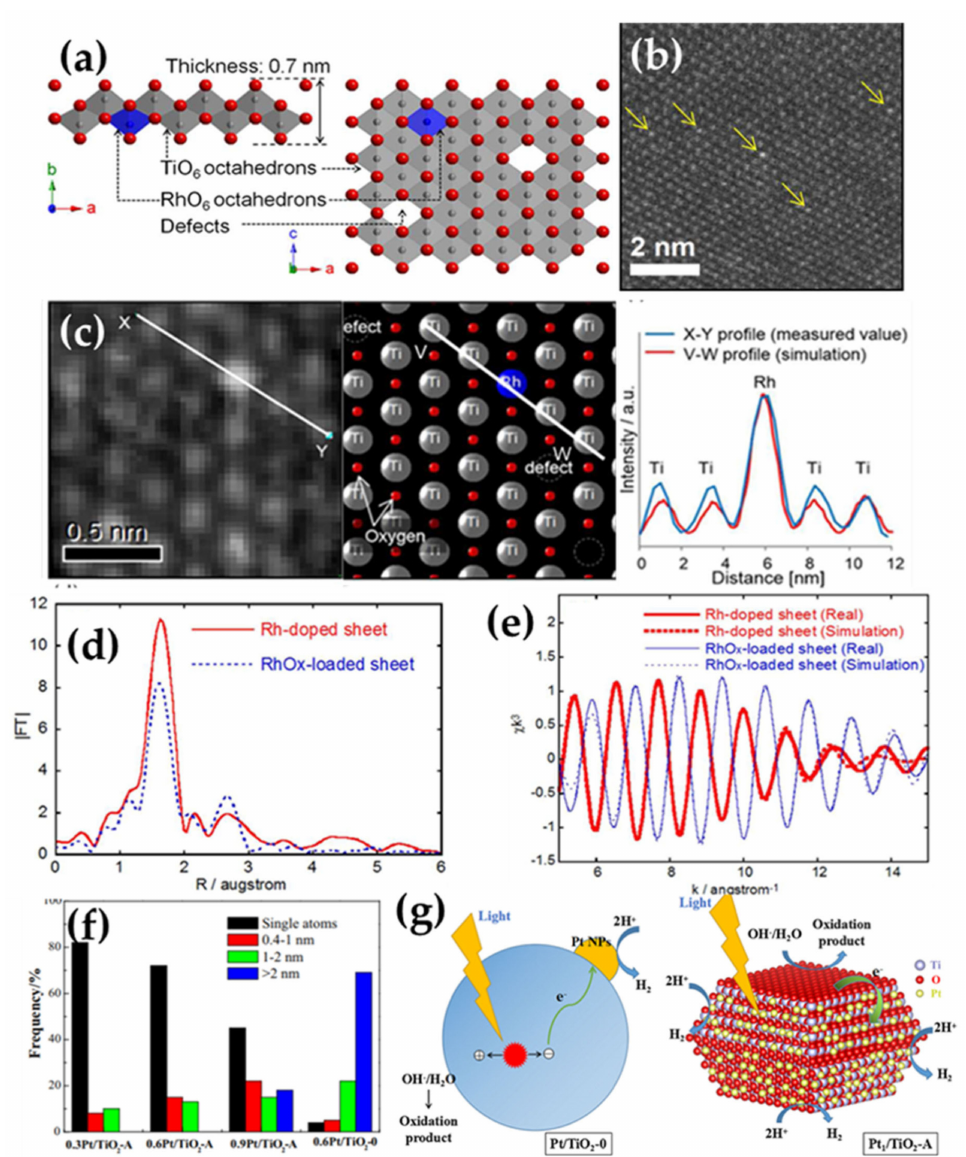
Figure 1. ( a ) Structural models of Rh-doped titania nanosheet from sectional view and plan view [36]; ( b ) HAADF-STEM (200 kV) image of Rh (x = 0.026)-doped Ti 1.82 − xRh x O 4 nanosheet [36]; ( c ) mag- nified HAADF-STEM image (80 kV) and corresponding structural model of Rh (x = 0.026)-doped nanosheet, with intensity profiles along the line X − Y in the actually observed image and the line V − W in the simulated image [36]; ( d ) Fourier transforms of Rh K-edge k 3 -weighted EXAFS for Rh (x = 0.026)-doped and RhO x -loaded titania nanosheet [36]; ( e ) Inversely Fourier-transformed spectra for Rh-doped nanosheet and RhO x -loaded nanosheet for the peak at around 2.8 Å in panel a [36]; ( f ) Size distribution of 0.3Pt 1 /TiO 2 -A, 0.6Pt 1 /TiO 2 -A, 0.9Pt 1 /TiO 2 -A, and 0.6Pt/TiO 2 -0 [22]; and ( g ) Illustration of the charge transfer and H 2 evolution in Pt/TiO 2 -0 and synthesized Pt 1 /TiO 2 -A